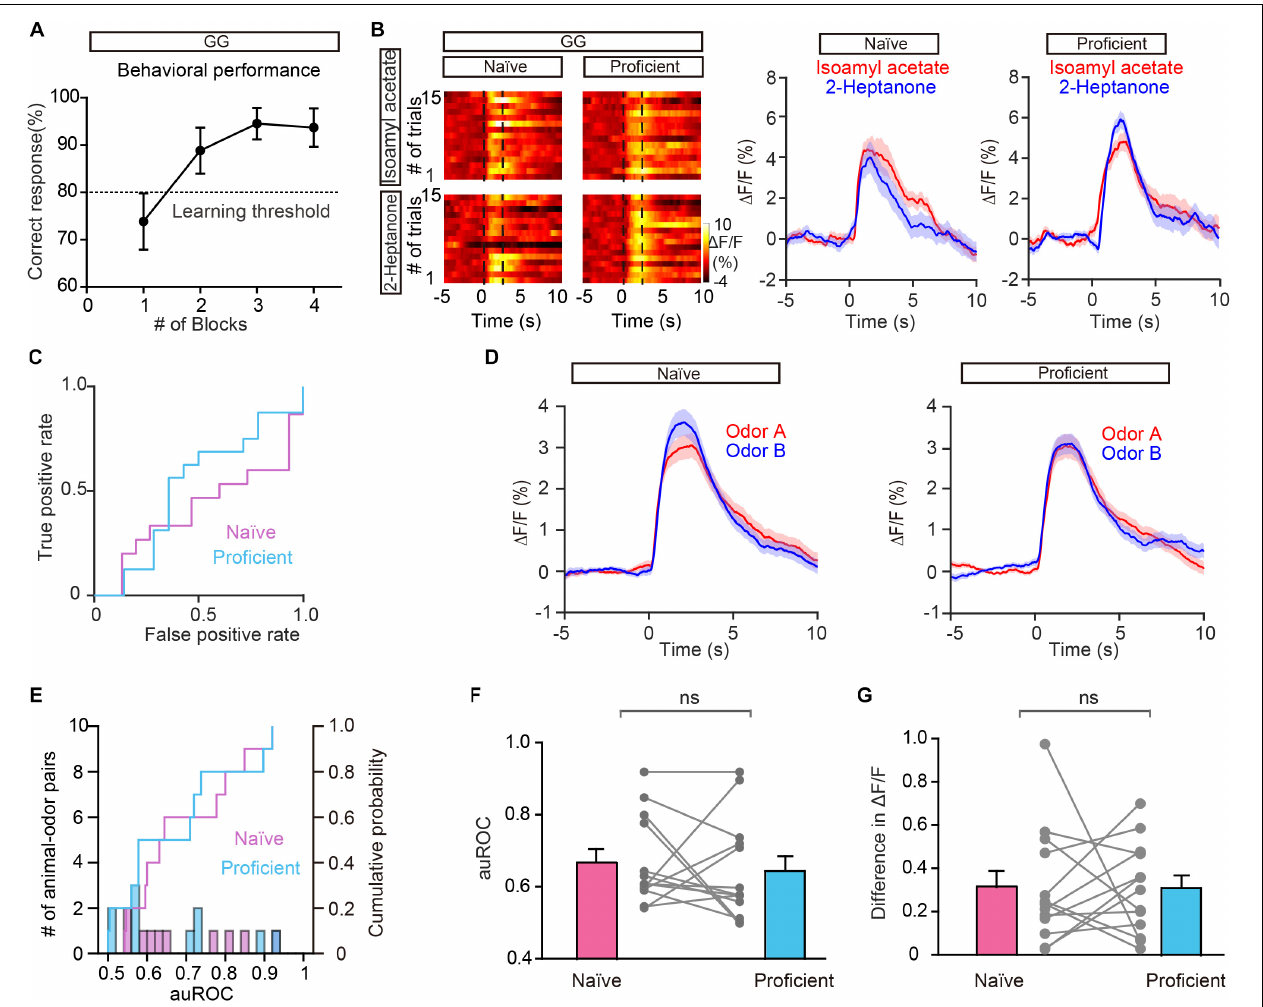
FIGURE 5 | Odor responses in GCs do not show separation during the go/go (GG) task. (A) Percentage of correctly answered trials in the last session of the go/go task. (B,C) Heat map (B) , peri-event plot (B) , and ROC graph (C) of Ca 2 + signals from an individual mouse in the naïve stage and in the proficient stage of the go/go task. (D) Averaged traces of odor responses across all animal-odor pairs ( n = 13 animal-odor pairs from ten mice). Odor A and odor B represent the two rewarded odors delivered during the go/go task. (E) Histograms and cumulative probability of auROCs in the naïve stage and the proficient stage. (F,G) auROCs (F) and the difference in (cid:49) F/F (G) are not significantly different between the naïve stage and the proficient stage. [ (F) Wilcoxon’s sign rank test, W = 14.0, P = 0.622; (G) Wilcoxon’s sign rank test, W = -15.0, P =